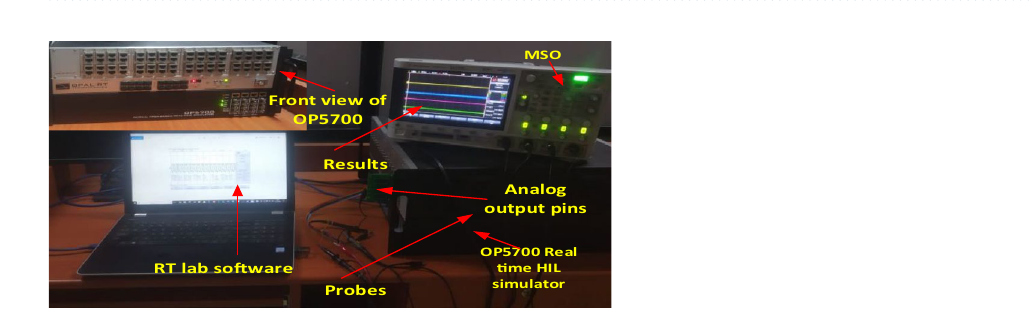
Figure 7. Hardware setup of HIL